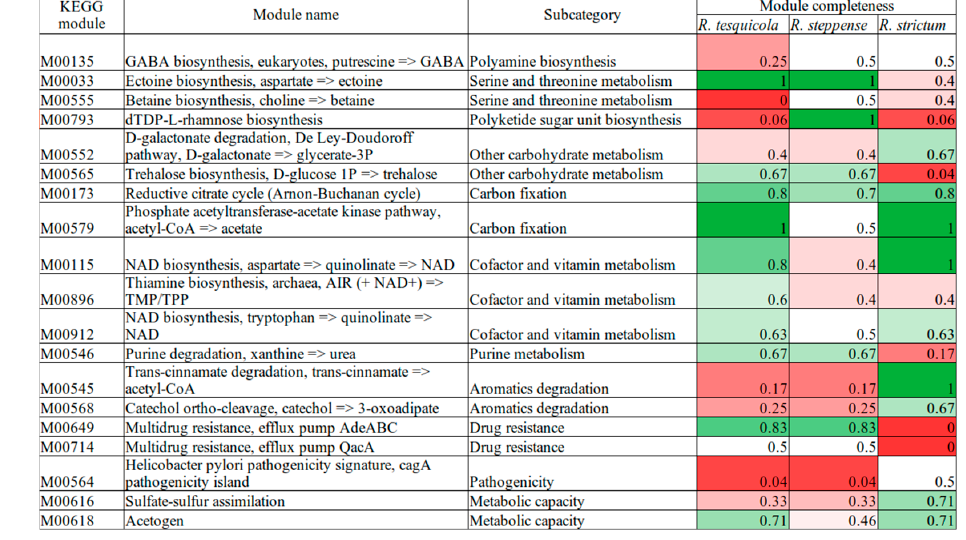
Figure 3. Completeness of the most different KEGG modules for three Rhodovulum genomes. Colors indicate the completeness of the module: red for the least complete, green for the most complete.